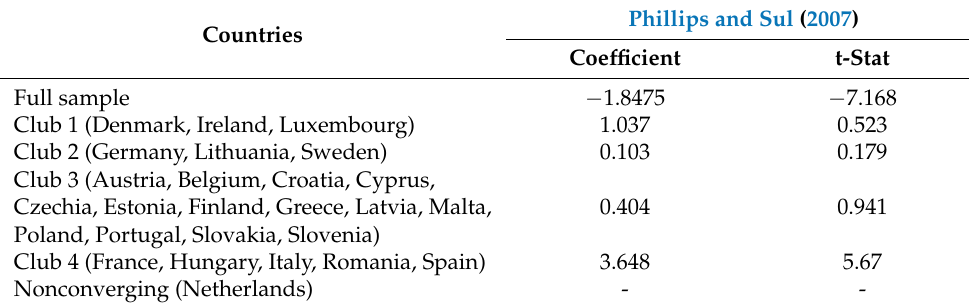
Table 4. Country convergence for the period 2009–2021 (deficit to GDP